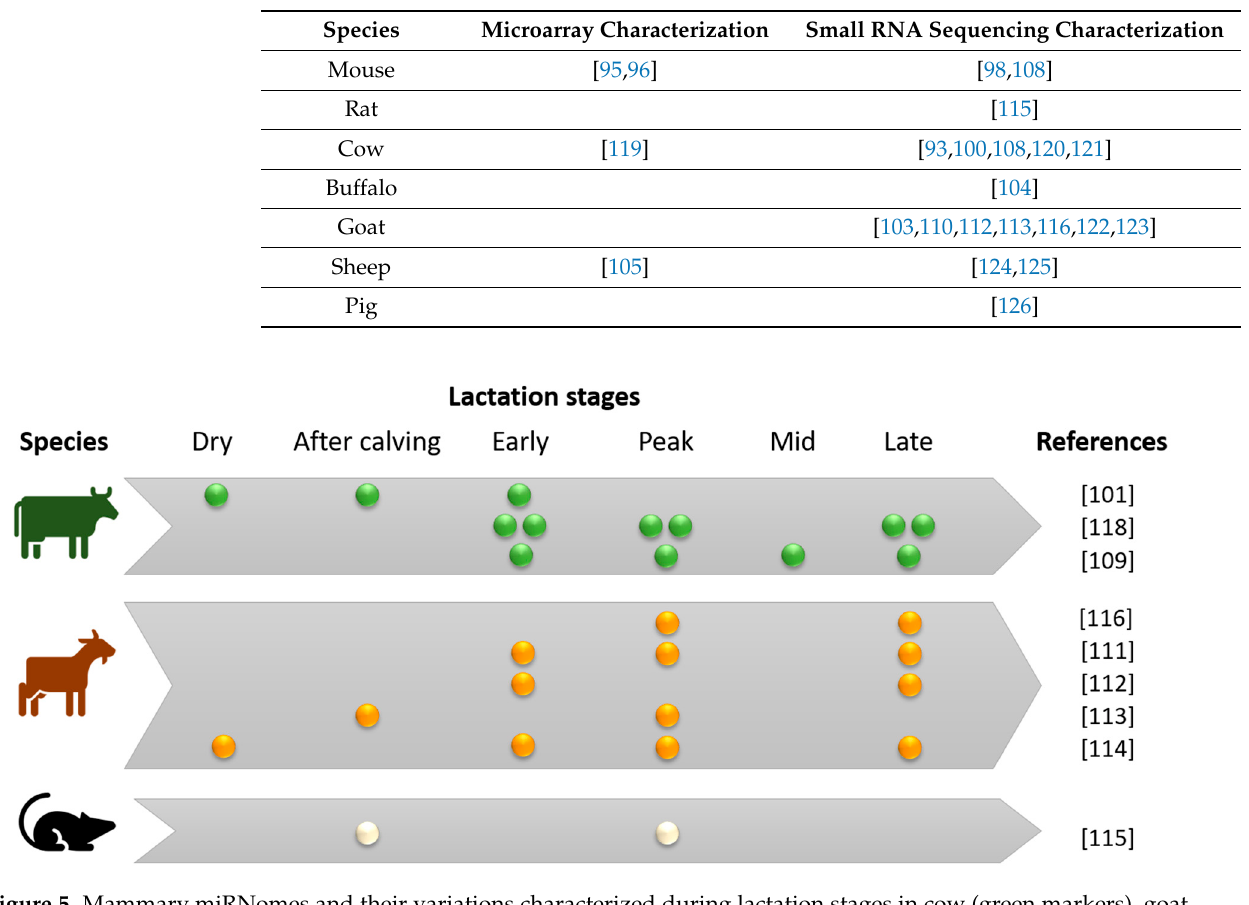
Figure 5. Mammary miRNomes and their variations characterized during lactation stages in cow (green markers), goat (orange markers), and rat species (white markers).